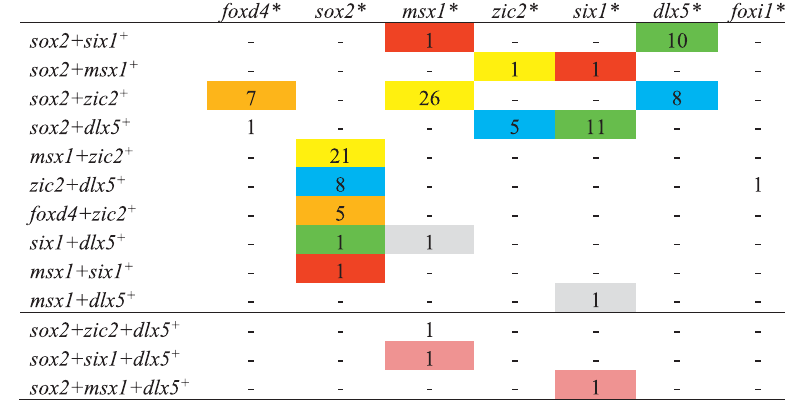
Cells labeled with the same color co-expressed the same combination of three or four domain-enriched transcription factors. *Transcription factor dataset that was queried. + The transcription factor that was co-expressed with the factor at the top of each column.